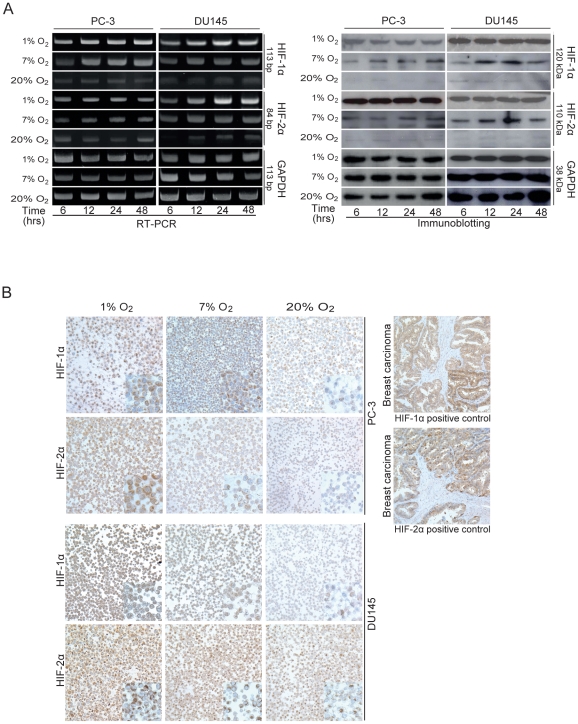
Hypoxia increases the expressions of HIF-1α and HIF-2α.(A) In comparison to the cells cultivated at 20% O2, the cells cultivated at 7% O2 show higher levels of HIF-1α and HIF-2α, and the cells cultivated at 1% O2 show the highest levels of HIF-1α and HIF-2α by both RT-PCR and immunoblotting. (B) Immunocytochemistry reveals higher levels of HIF-1α and HIF-2α expressions in the cells cultivated under 7% O2 and the highest levels of HIF-1α and HIF-2α expressions in the cells cultivated under 1% O2 for both cell lines. The breast carcinoma sections were used as positive controls for both HIF-1α and HIF-2α. All photos were originally taken at 200× and all the insets were taken at 400×.